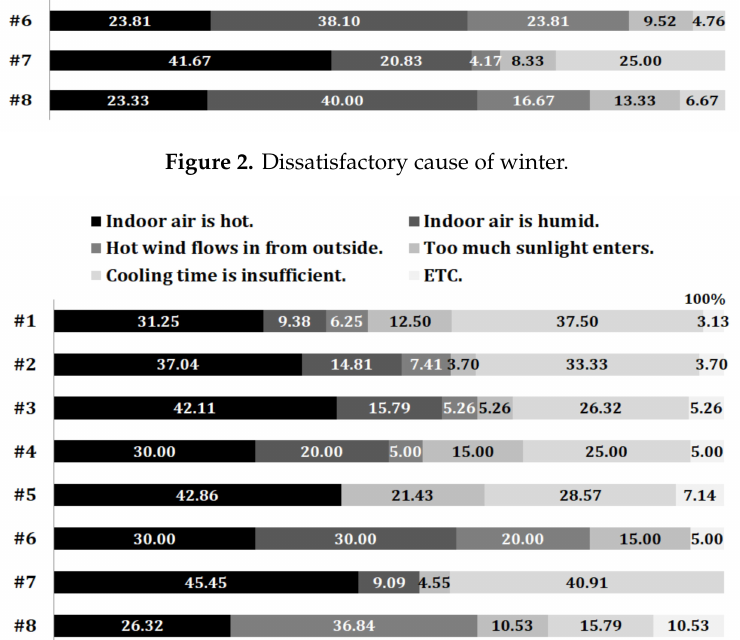
Figure 3. Dissatisfactory cause of